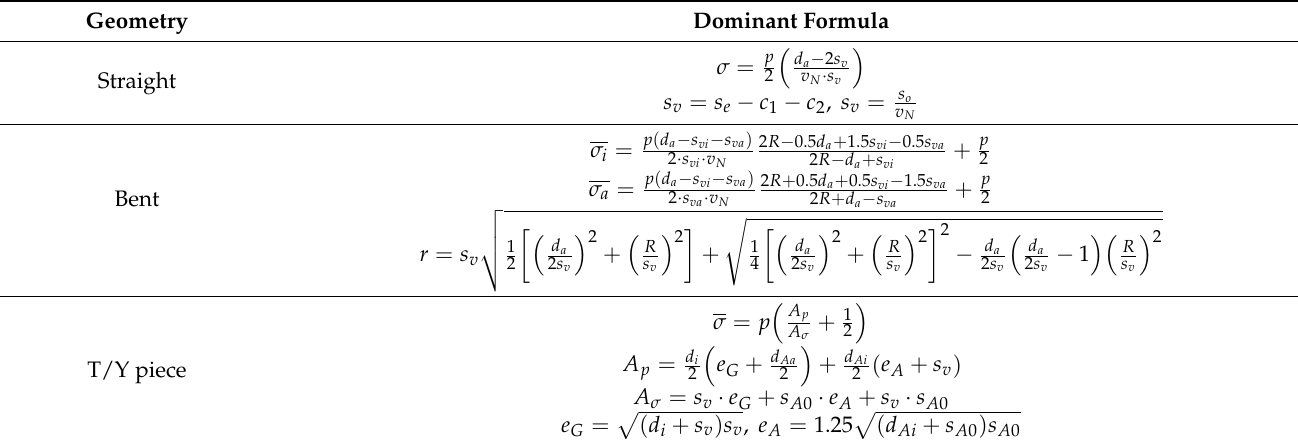
Table 1. Stress-calculation formula based on the TRD